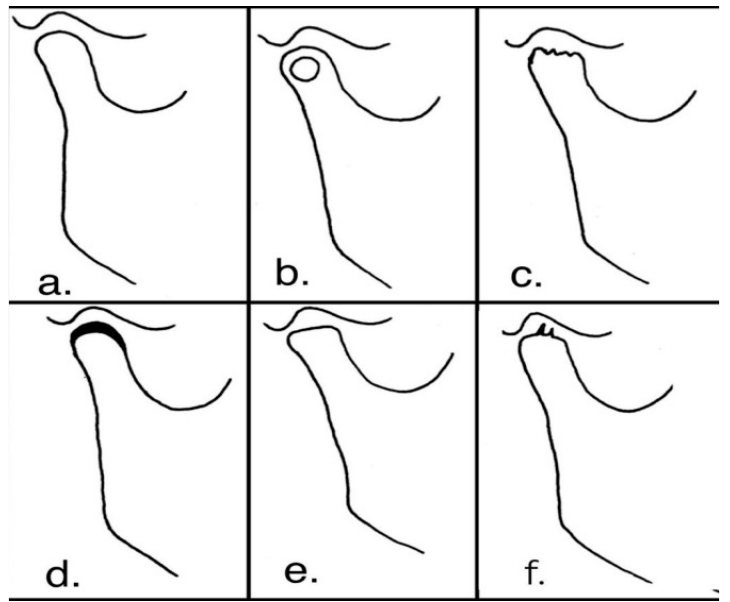
Figure 1. Condylar changes. ( a ) Normal condyle. ( b ) Subcortical cyst. ( c ) Erosion. ( d ) Sclerosis. (e) Flattening. ( f ) Osteophytes.